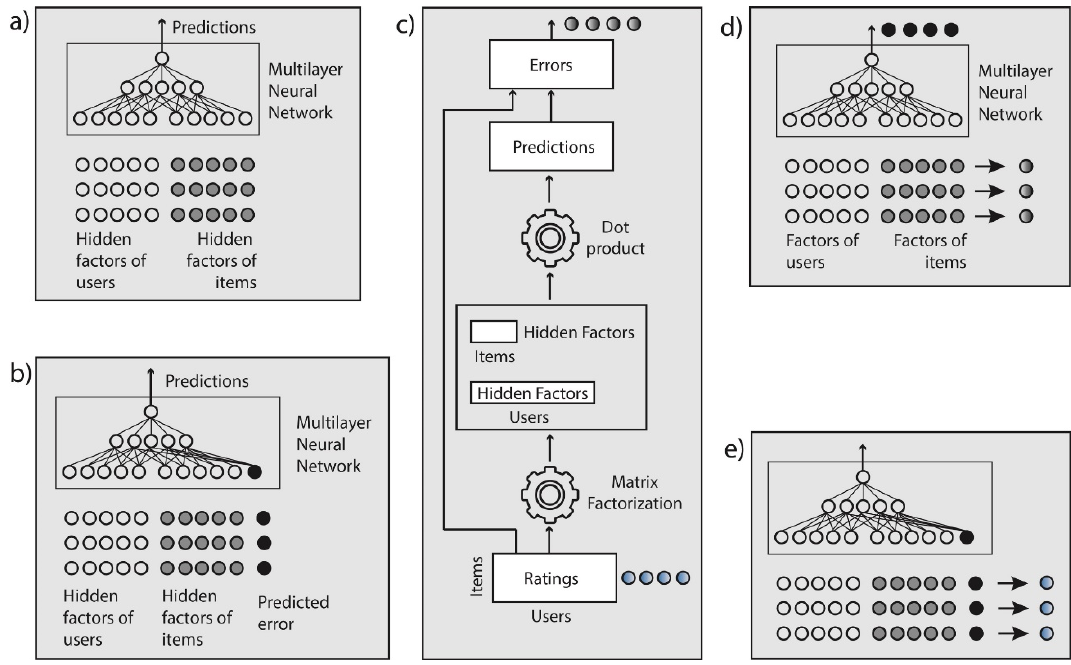
Figure 2. Proposed method (RNCF) concepts: (a) NCF baseline, (b) improved NCF by adding reliabilities, (c) extraction of the hidden factors and the real prediction errors, (d) prediction of the errors (reliabilities), (e) training stage in the RNCF architecture. NCF: Neural Collaborative Filtering, RNCF: Reliability-based Neural Collaborative Filtering.